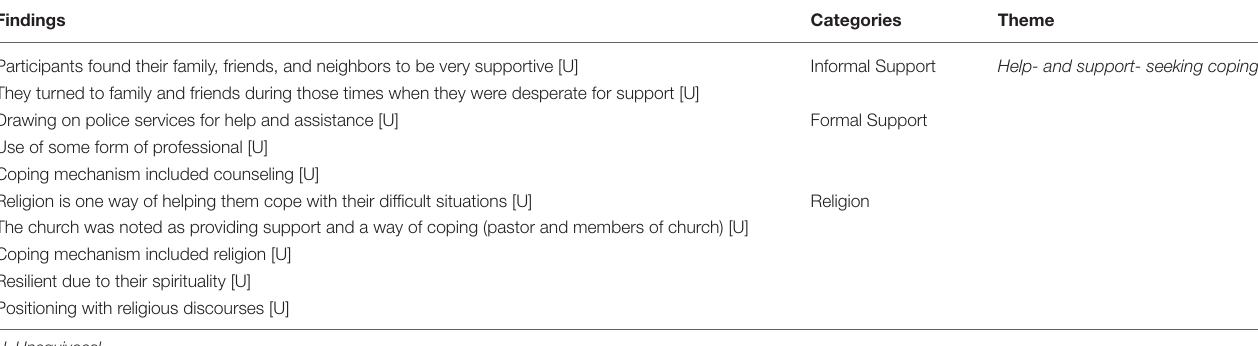
TABLE 5 | Theme 2: Emotional regulation coping.